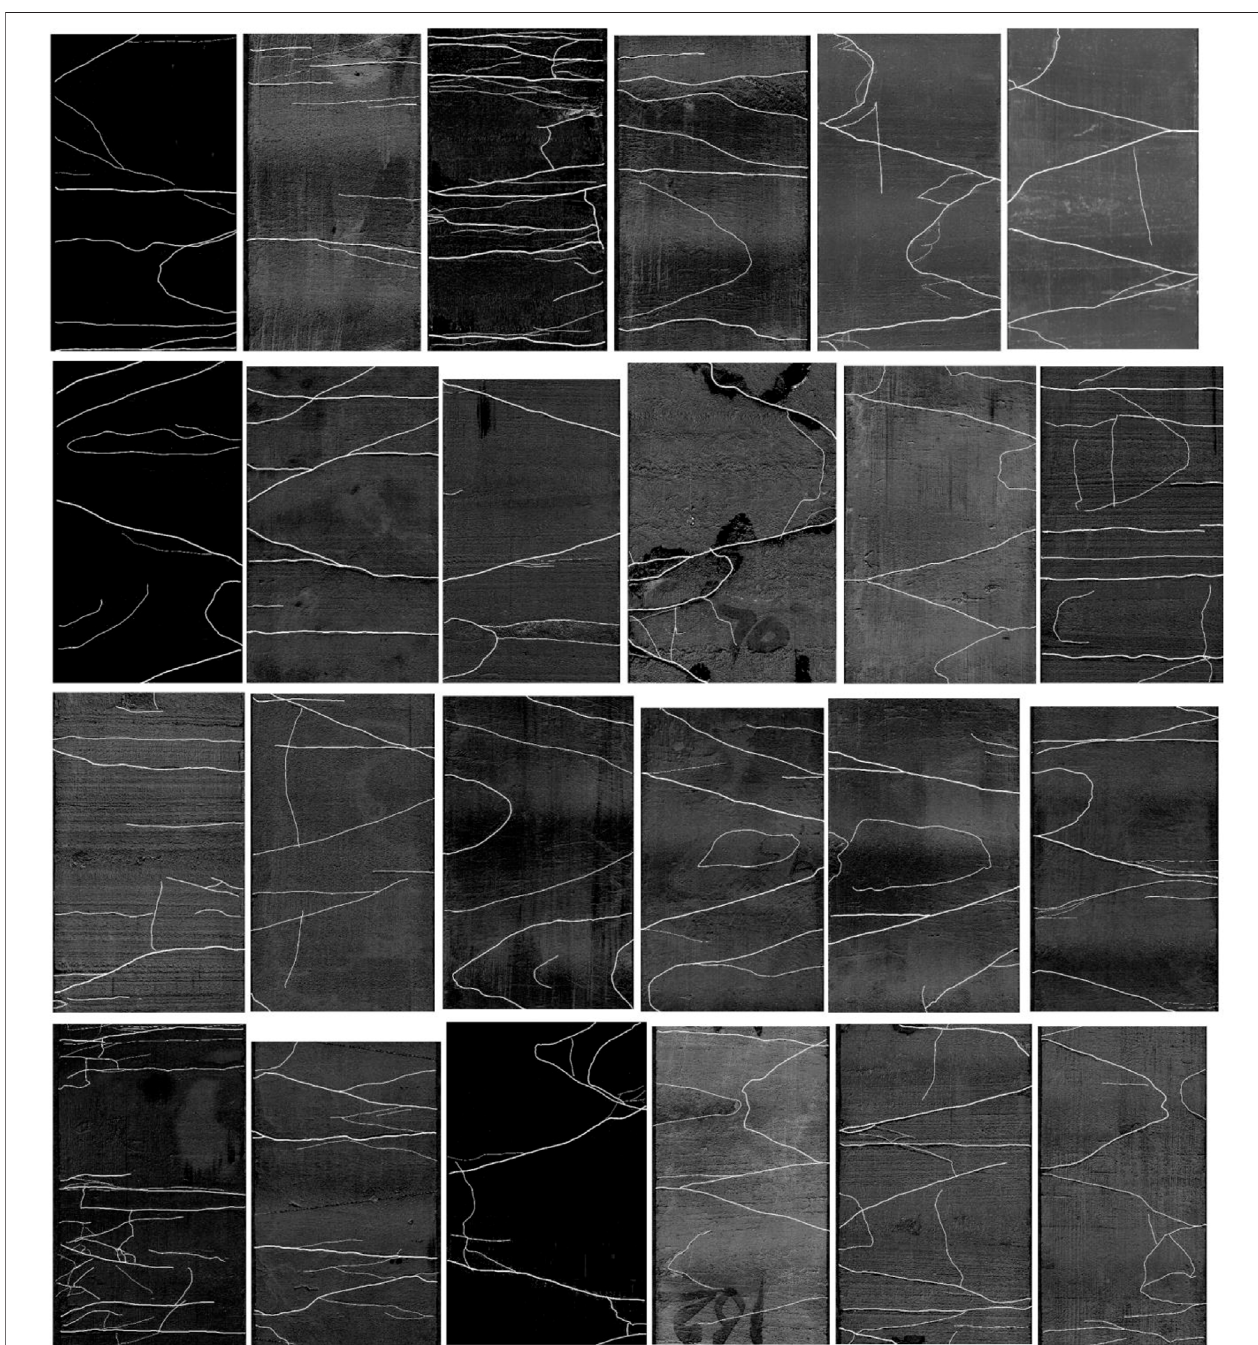
FIGURE 9 | Crack extraction results of the lateral surface expansion map of 24 cores after compression test.